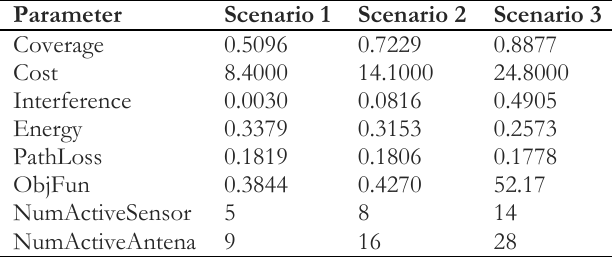
Table 12. Comparison of the results obtained from the GA algorithm for different scenarios.